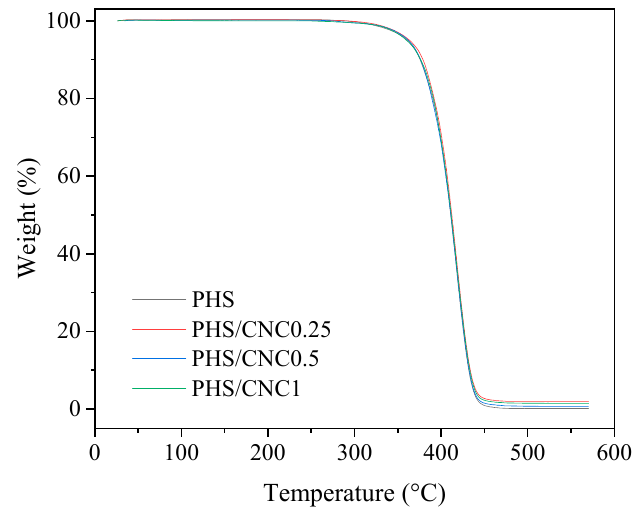
Figure 2. TGA traces of PHS and PHS/CNC